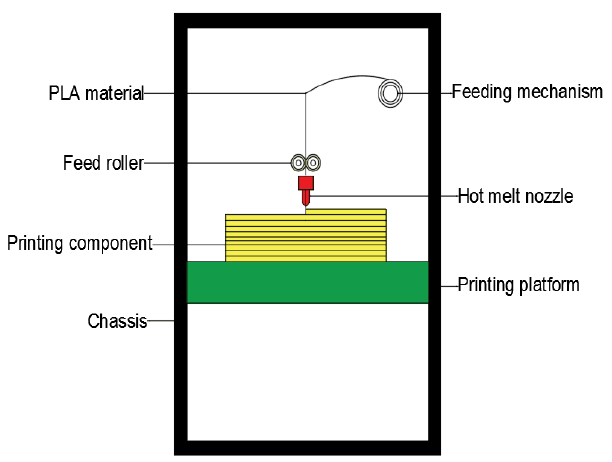
Figure 1. DF-G450 working principle diagram.